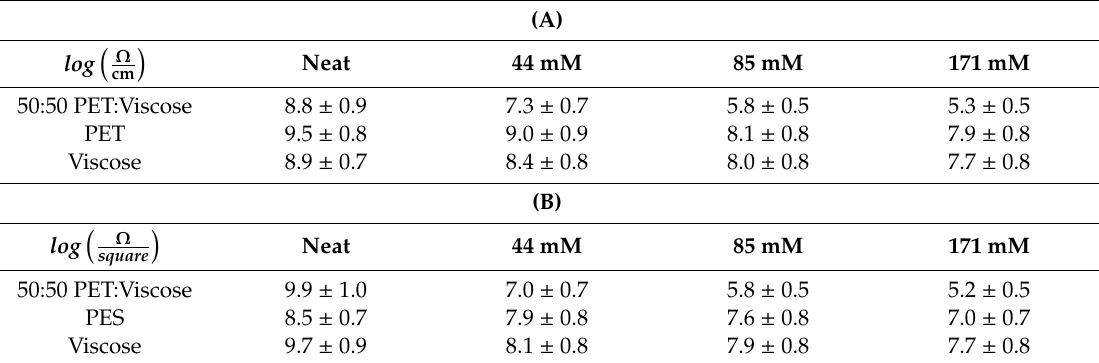
Table 1. Resistivity of polyaniline emeraldine salt coated fabrics—( A ) volume and ( B ) surface resistivity.